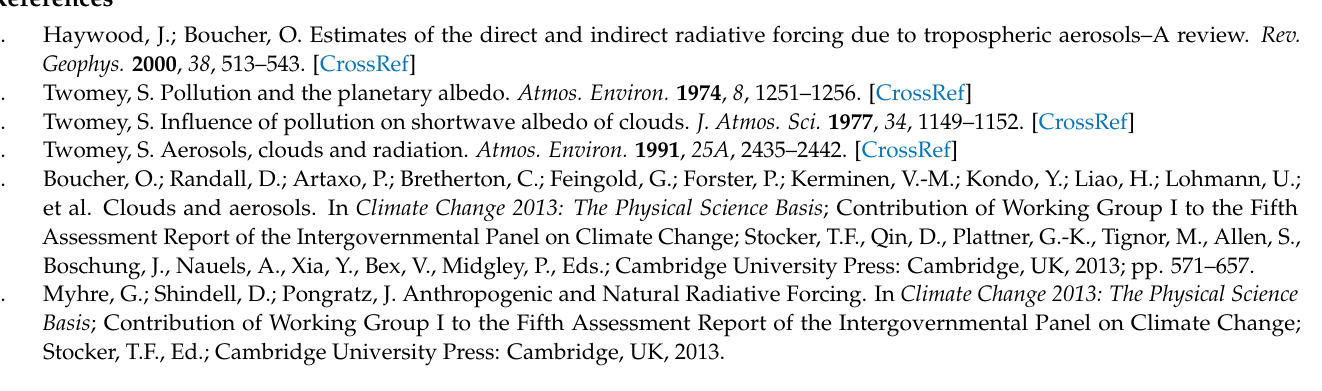
List of acronyms; Figure S1: Vertically integrated column droplet number concentration (per m 2 ) averaged for the periods–( a ) JFM2014 and ( b ) JAS2019 in BAM AMIC experiments; Figure S2: Surface concentration (per cm 3 ) of CCN at 0.5% supersaturation averaged for the periods–( a ) JFM2014 and ( b ) JAS2019 in BAM AMIC experiments; Figure S3a: Model evaluation of cloud optical properties for JFM2014; Figure S3b: Model evaluation of cloud optical properties for JAS2019; Figure S4: Model evaluation of downward shortwave radiation for JFM2014 and JAS2019; Figure S5: 2-m tempera- ture (top panel) and specific humidity (bottom panel) in BAM CTRL and BAM AMIC simulations averaged for the periods–JFM2014 and